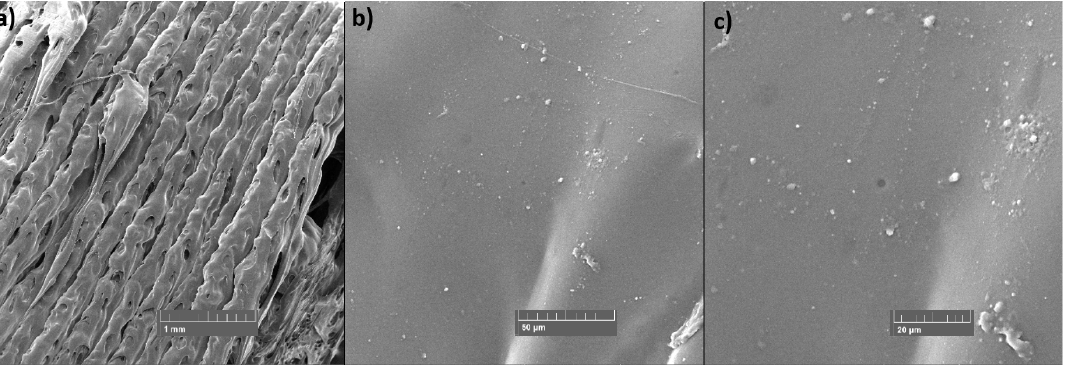
Figure 14. SEM micrographs of the 3D-printed static mixer for the PET-G 1.5T 0.25C sample at ( a ) 50 × , ( b ) 1000 × and ( c ) 2000 × magnification.